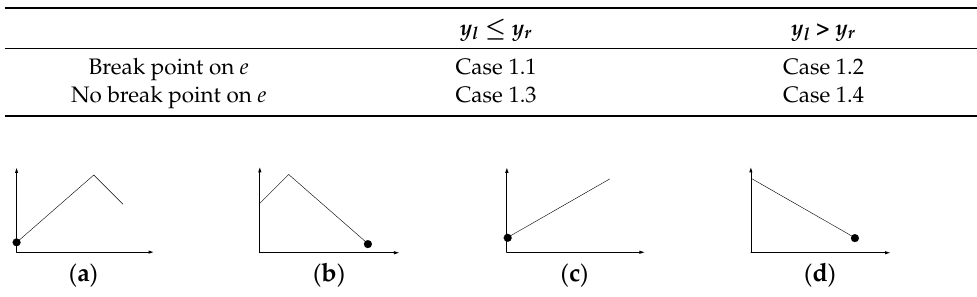
( f ) Figure A3. dist ( o , p ) × CI ( Q , p ) graphs for Case 2: ( a ) case 2.1, ( b ) case 2.2, ( c ) case 2.3, ( d ) case 2.4, ( e ) case 2.5, and ( f ) case 2.6. The proofs of Cases 2.1–2.4 are identical to those of Cases 1.1–1.4. In Cases 2.5–2.6, lowDist ( G i , p ) is a non-negative number less than or equal to the distance from p to any given vertex in G i ; in addition, p belongs to G i , and dist ( p , p ) = 0. Thus, lowDist ( G i , p ) ≤ 0 ≤ dist ( o , p ). Because CI ( Q , p ) ≥ 0, CI( Q , p ) × lowDist ( G i , p ) = LB ( G i , p ) ≤ CI( Q , p ) × dist ( o , p ). Case 3. CI (Q , p ) < 0 and p does not belong to G i . This case can be divided into four subcases depending on two conditions. Again, we let dist ( o , e . l ) be y l and dist ( o , e . r ) be y r . As shown in Table A8, the two conditions are as follows: (1) Are there any break points on e ? (2) Is y l less than or equal to y r ? Table A8. Four subcases of Case 3. y l ≤ y r y l > y r Break point on e